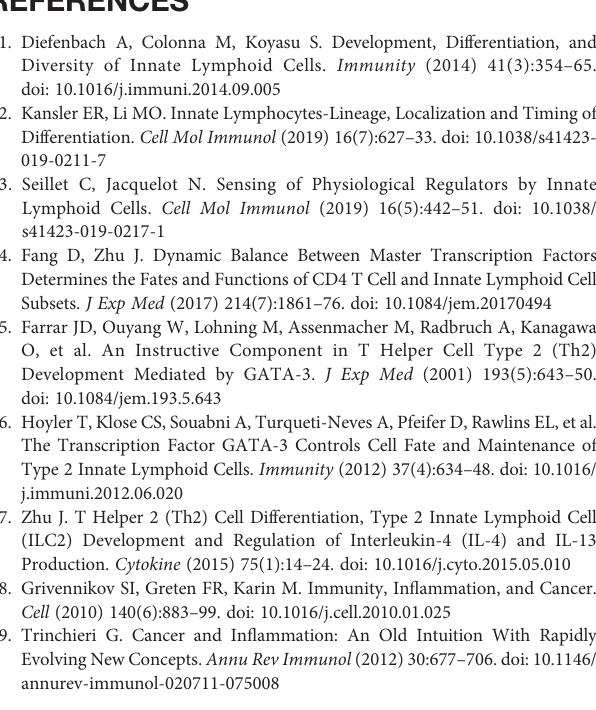
Supplementary Figure 3 | The expression of immune checkpoint molecules in ILC2s. (A) Gene expression of immune checkpoint molecules of ILC2s from health donorsandNSCLCpatients.ILC2sweresortedbyFACS.ThemRNAexpressionof other immune checkpoint genes in ILC2s from HD-PB, LU-PB and LU-CA samples was tested by qPCR (for each group, n=18). (B) The proportions of PD-1 expression in ILC2s from LU-CA and LU-N samples (for each group, n=5). NS, not signi fi cant,* P <0.05.In (A) , P valueswerecalculatedbyone-wayANOVA,posthoc comparisons, Tukey ’ s test. In (B) , P values were calculated by non-paired two- tailed Student t-test. Supplementary Figure 4 | Gene expression of surface markers, immune checkpoint molecules and functional molecules of PD-1high and PD-1low ILC2s from tumor tissue of NSCLC patients. PD-1high ILC2s and PD-1low ILC2s were marked and sorted as described in Figure 4 . (A) The mRNA expression of surface marker genes of ILC2s sorted from HD-PB, LU-PB and LU-CA samples (n=26). (B) ThemRNAexpressionofotherimmunecheckpointgenesinILC2sfromHD-PB, LU-PB and LU-CA samples. (C) The mRNA expression of other functional genes in ILC2s from HD-PB, LU-PB and LU-CA samples. NS, not signi fi cant, * P < 0.05. P values were calculated by paired two-tailed Student t-test. Supplementary Figure 5 | PD-1high ILC2s boosted M2 related genes expression and downregulated M1 related genes through secreting IL-4 and IL-13. (A, B) PD-1high ILC2s culture supernatant downregulated M1 related genes (TNF, IL6 and CCL5) expression (A) and upregulated M2 related genes (TGFB1, CCL18 and ARG1) expressions (B) . (C) Anti-IL-4 antibody and/or anti-IL-13 antibody weakened the upregulation of M2 related genes expression in CD14+ cells treated by PD-1high ILC2s culture supernatant. NS, not signi fi cant, * P < 0.05, ** P < 0.01, *** P < 0.001, **** P < 0.0001. P values were calculated by one-way ANOVA, post hoc comparisons, Tukey ’ s